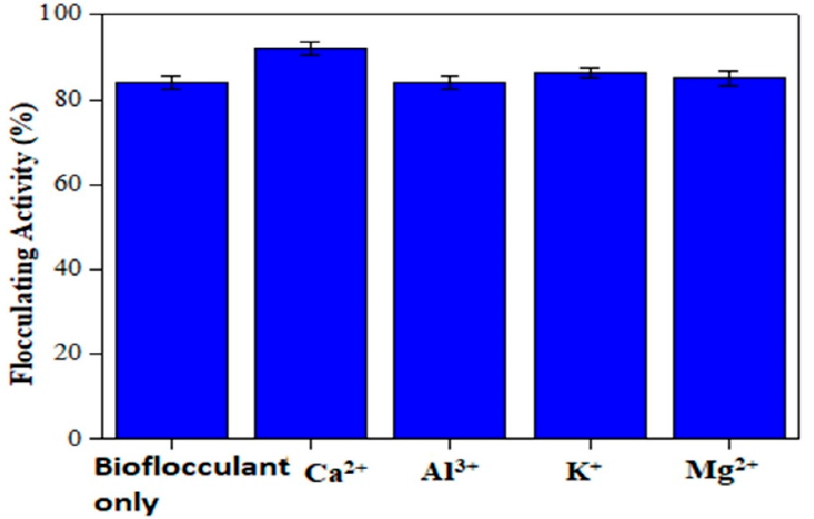
Figure 4. The effect of cations concentration on the flocculating activity of bioflocculant dosage from Bacillus nitratireducens towards EBT solution. Experiment composition: 10 mL of EBT (1 g/L) with 390 mL of deionized (D.I), pH 2 adjusted with NaOH (1 M) and/or H 2 SO 4 (0.5 M), 100 mL of nutrient broth containing Bacillus nitratireducens, and 5 mL of salt solution (CaCl 2 , AlCl 3 , KCl, or MgCl 2 ) at a concentration of 10 g/L (except for the experiments with only bioflocculant, with no salt).